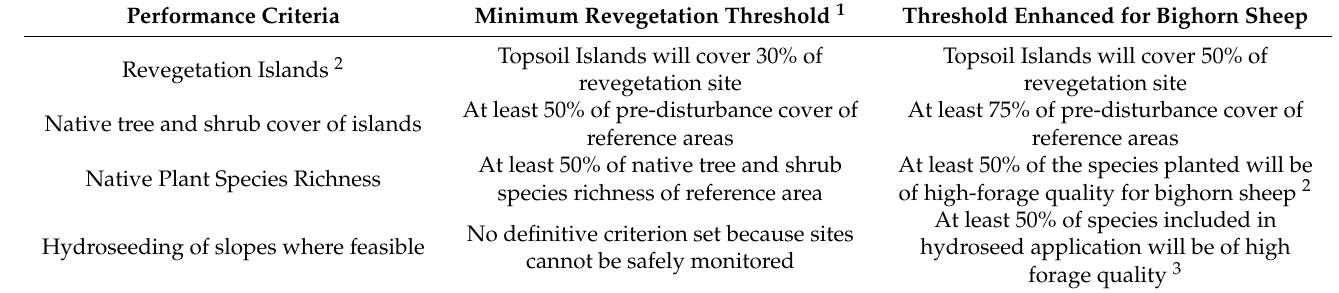
Table A3. Proposed performance criteria for mine revegetation sites contributed to the Bighorn Habitat